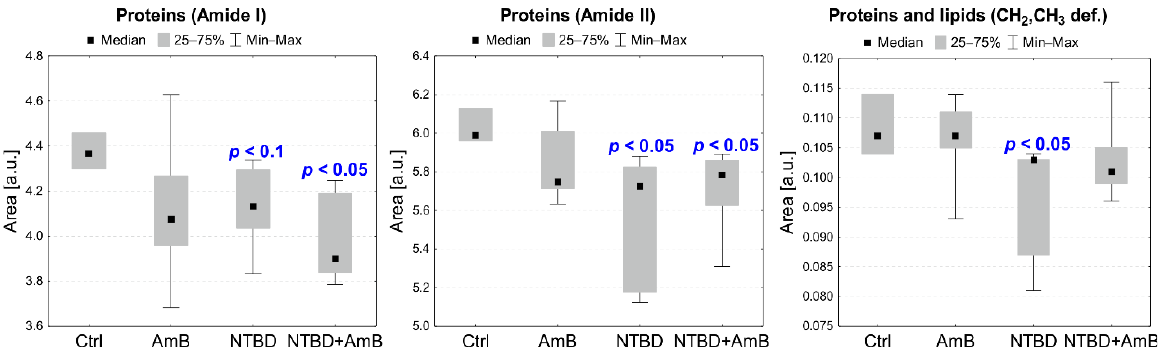
Figure 10. Median, minimal, and maximal values of intensities of selected absorption bands presenting differences between RPTEC subjected to the NTBD, AmB, and NTBD+AmB treatment and the control (Ctrl) group. The p -values of the Mann – Whitney U test for statistically significant changes, compared to the control, are shown in the charts (red — increases, blue — decreases).